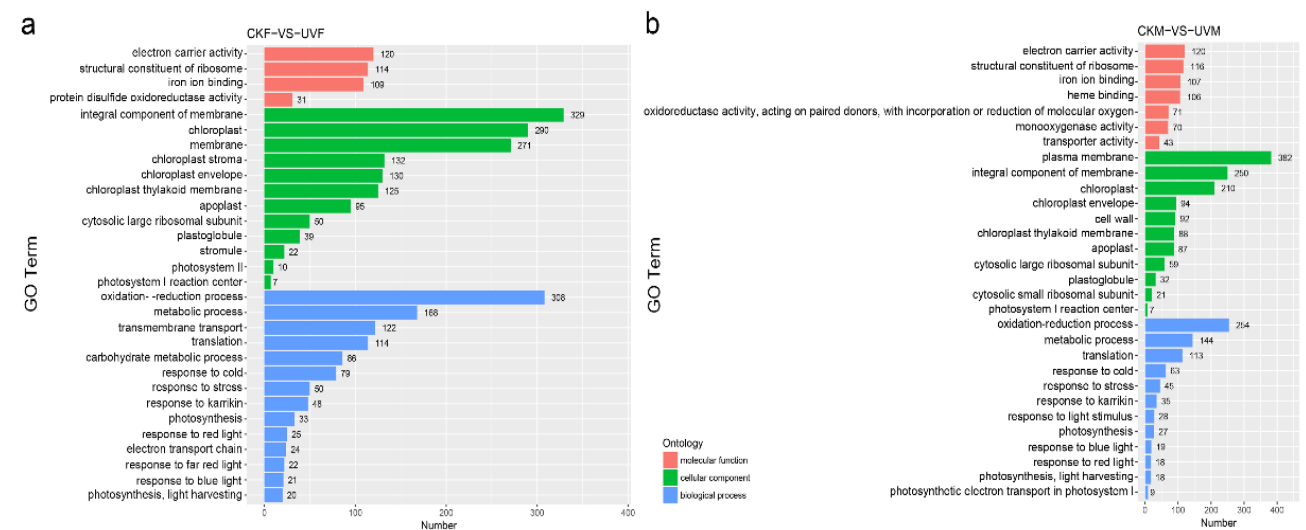
Figure 4. Gene ontology (GO) enrichment analysis of the DEGs detected in the CKF vs. UVF ( a ) and CKM vs. UVM ( b ) comparisons. The topmost enriched GO terms under the three main GO categories are shown.